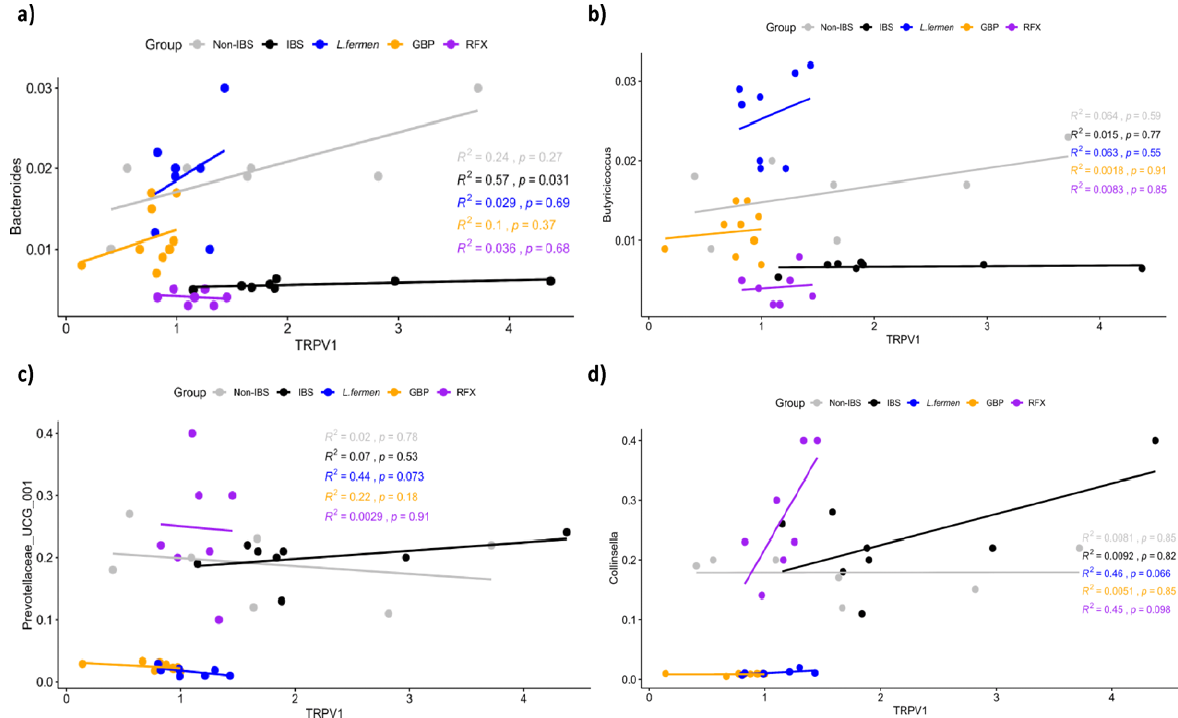
Figure 11. Correlation between Trpv1 expression and the abundance of ( a ) Bacteroides ( b ) Butyricicoccus ( c ) Prevotellaceae_UCG_001 and ( d ) Collinsella genus of DCA vehicle (Non-IBS), 4 mmol/L DCA (IBS)-, L. fermentum (10 9 CFU) ( L. ferm )-, Gabapentin at 70 mg/kg (GBP)- and Rifaximin at 150 mg/kg (RFX)-treated rats.